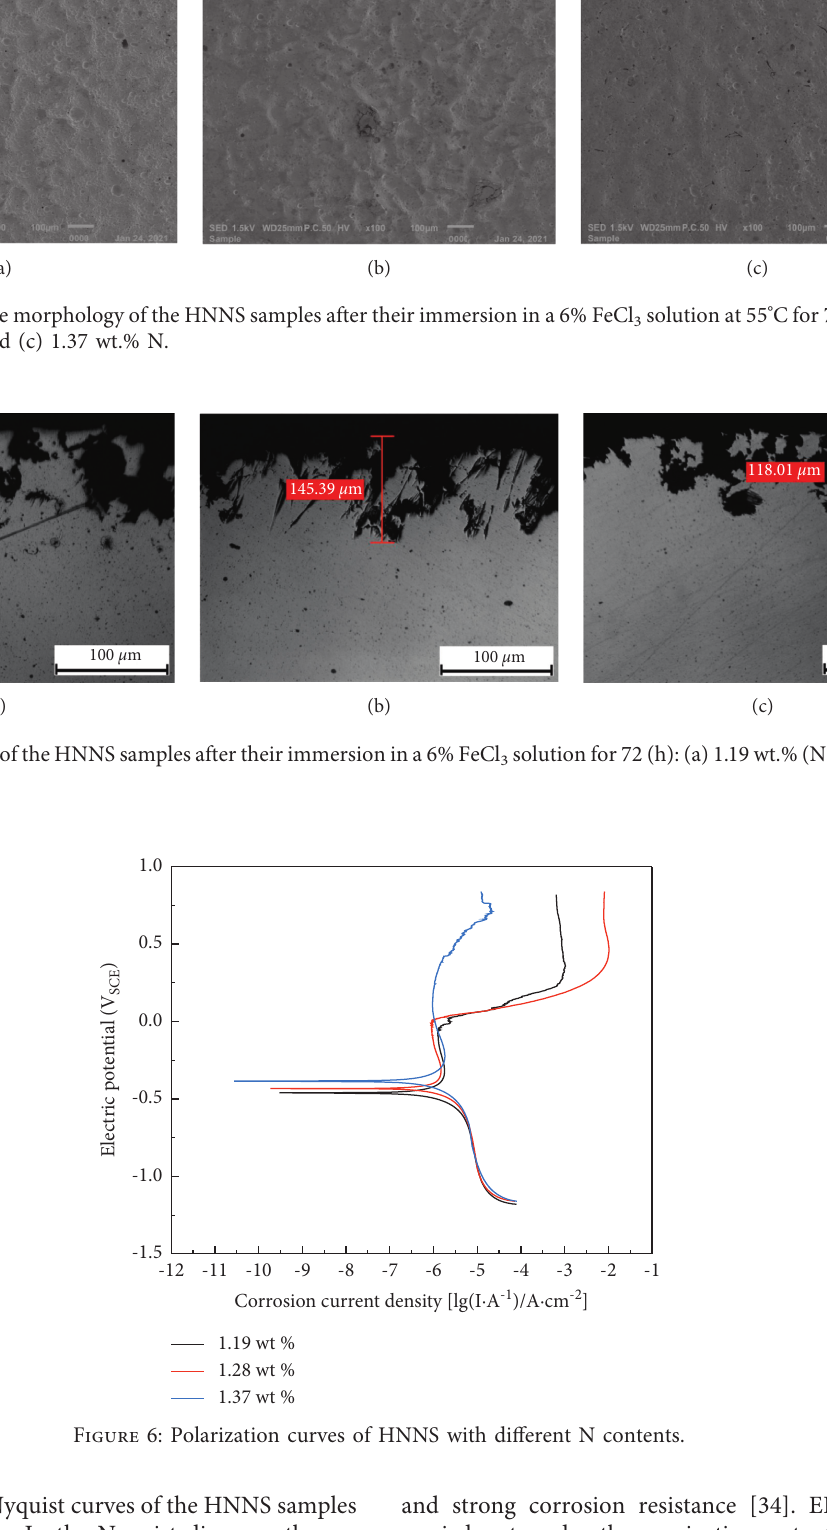
Figure 6: Polarization curves of HNNS with different N